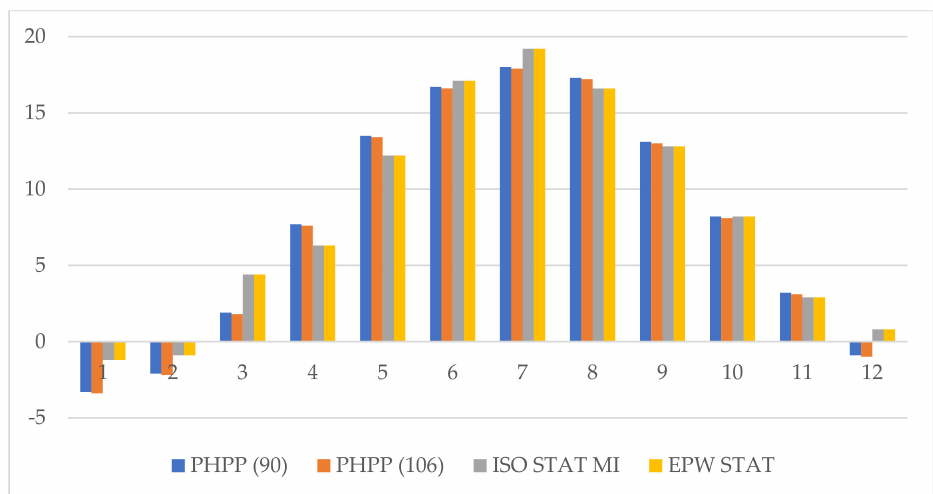
Figure 2. Comparison of average dry-bulb temperatures [ ◦ C] from ISO and EPW files and based on the data in the PHPP software. The ISO weather data available on the Ministry’s website and the EPW weather data are consistent. Source: own study based on the above-mentioned weather data.